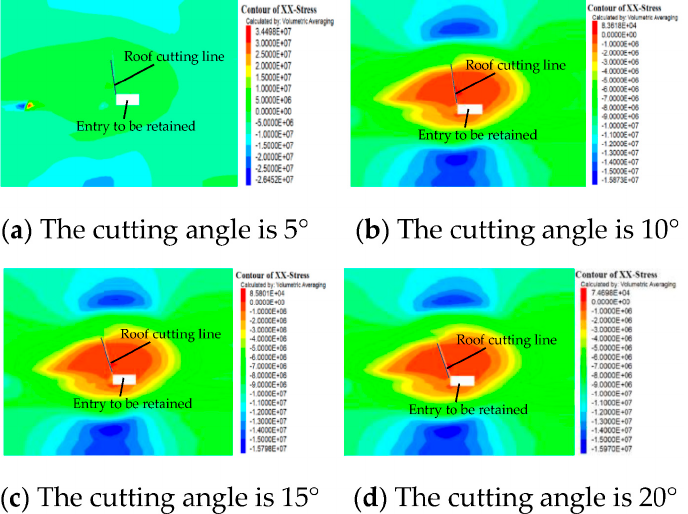
Figure 12. Horizontal stress of roadway surrounding rock under different cutting angles.